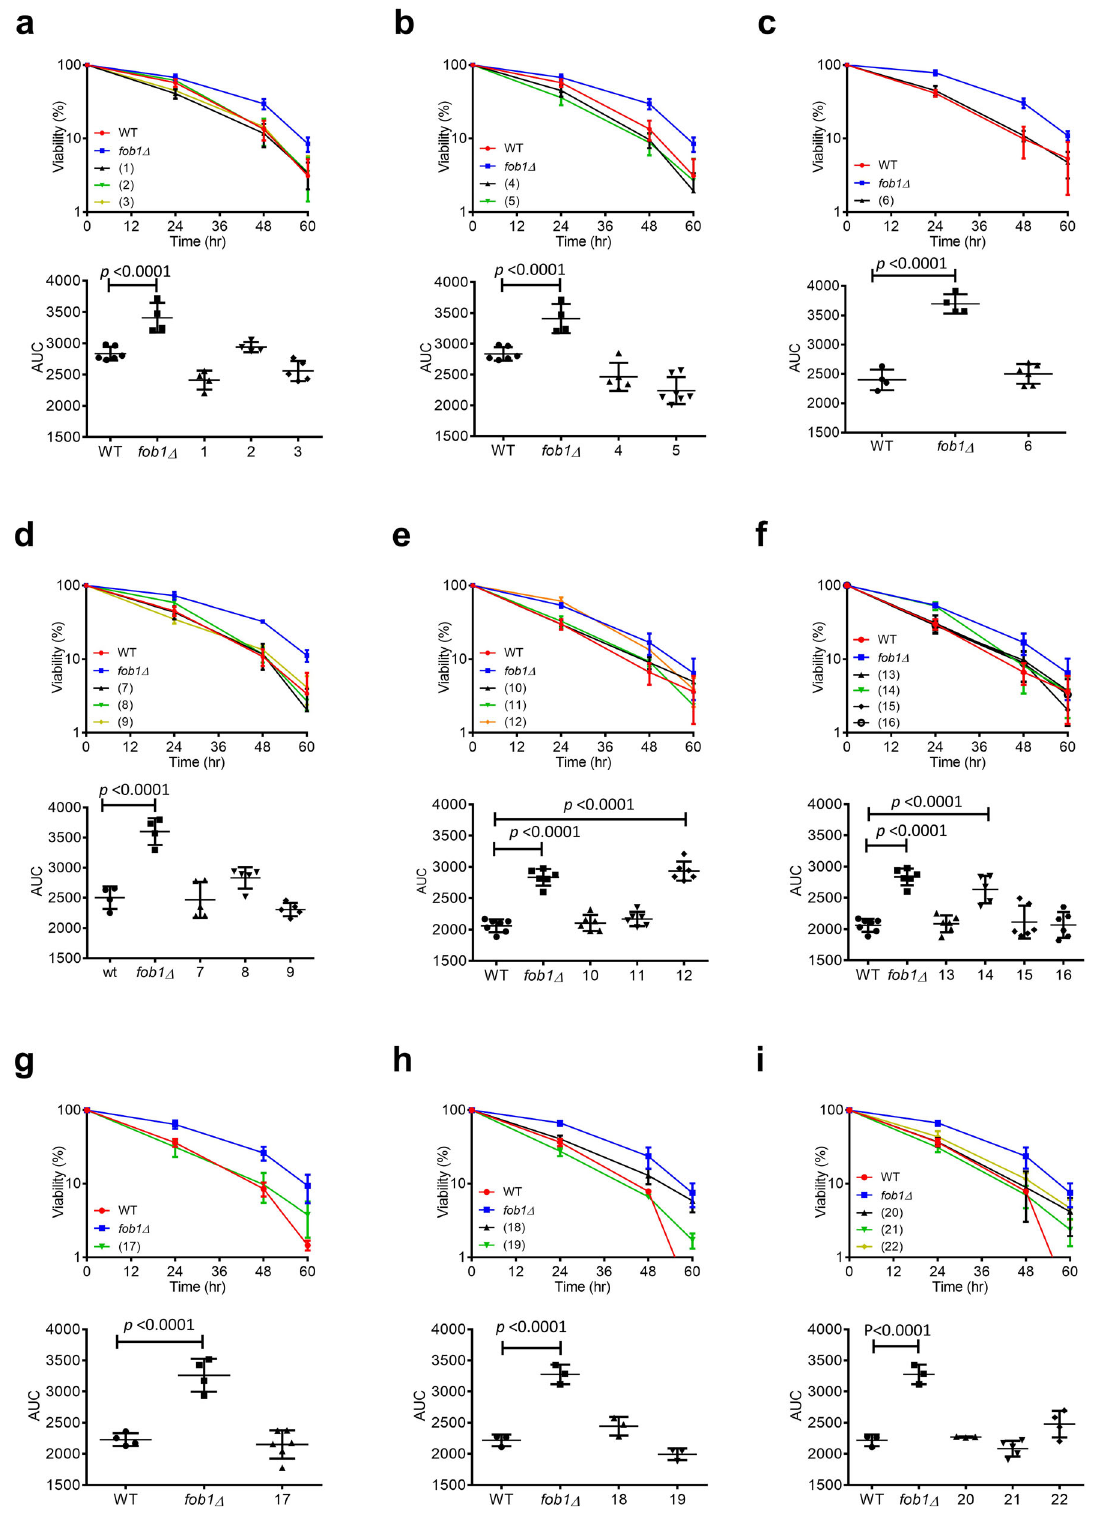
a Sir2-dependent or Tor1-dependent pathway by a micro- manipulation assay. As the data show, corylin promoted RLS in the sir2 Δ fob1 Δ double deletion strain (Fig. 4b) and failed to increase RLS in the tor1 Δ deletion strain (Fig. 4c), which is consistent with the data shown in Fig. 1f. This result suggested that corylin extends lifespan through the Tor1-dependent path- way. Tor (mTOR complex in mammals) is a key signaling